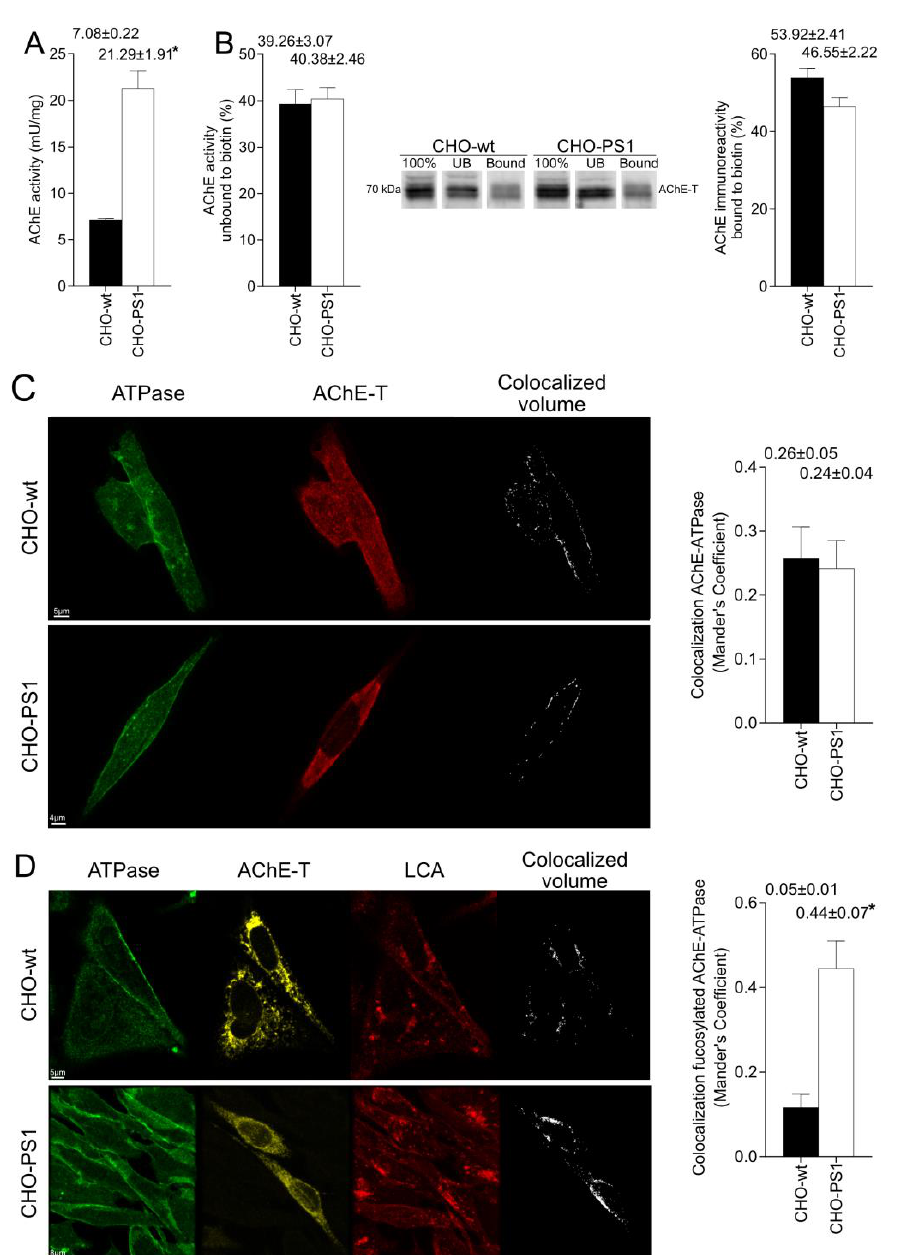
Figure 5. AChE activity and protein in plasmatic membrane of Chinese hamster ovary cells that overexpress PS1 (CHO-PS1) and wild-type (CHO-wt). CHO cells were transfected with AChE and PRiMA1 cDNAs to ensure expression of cholinergic AChE. After 48 h, AChE at the plasmatic membrane was analyzed. ( A ) AChE enzymatic activity was measured at the surface of the cell cultures by a modified Ellman method and normalized to membrane protein. n = 6 independent determinations from three independent experiments. ( B ) Biotinylation of cell surface proteins was assayed (n = 4 samples from each cell type of three independent experiments). Membrane proteins were labelled to biotin, and, after two hours, biotinylated proteins were separated from non-surface protein by interaction with NeutrAvidin. AChE enzymatic activity was measured in the fraction unbound to biotin and expressed as a percentage with respect to the total AChE of non-biotinylated samples (left panel). Biotinylation of AChE protein was analyzed by Western blotting of the unbound and bound fractions to biotin with respect to unbiotinylated sample. A representative Western blot is shown. To the right, densitometric quantification of AChE 70-kDa immunoreactive band in the frac- tion of membrane proteins labelled to biotin. ( C ) Localization of AChE in plasmatic membrane was